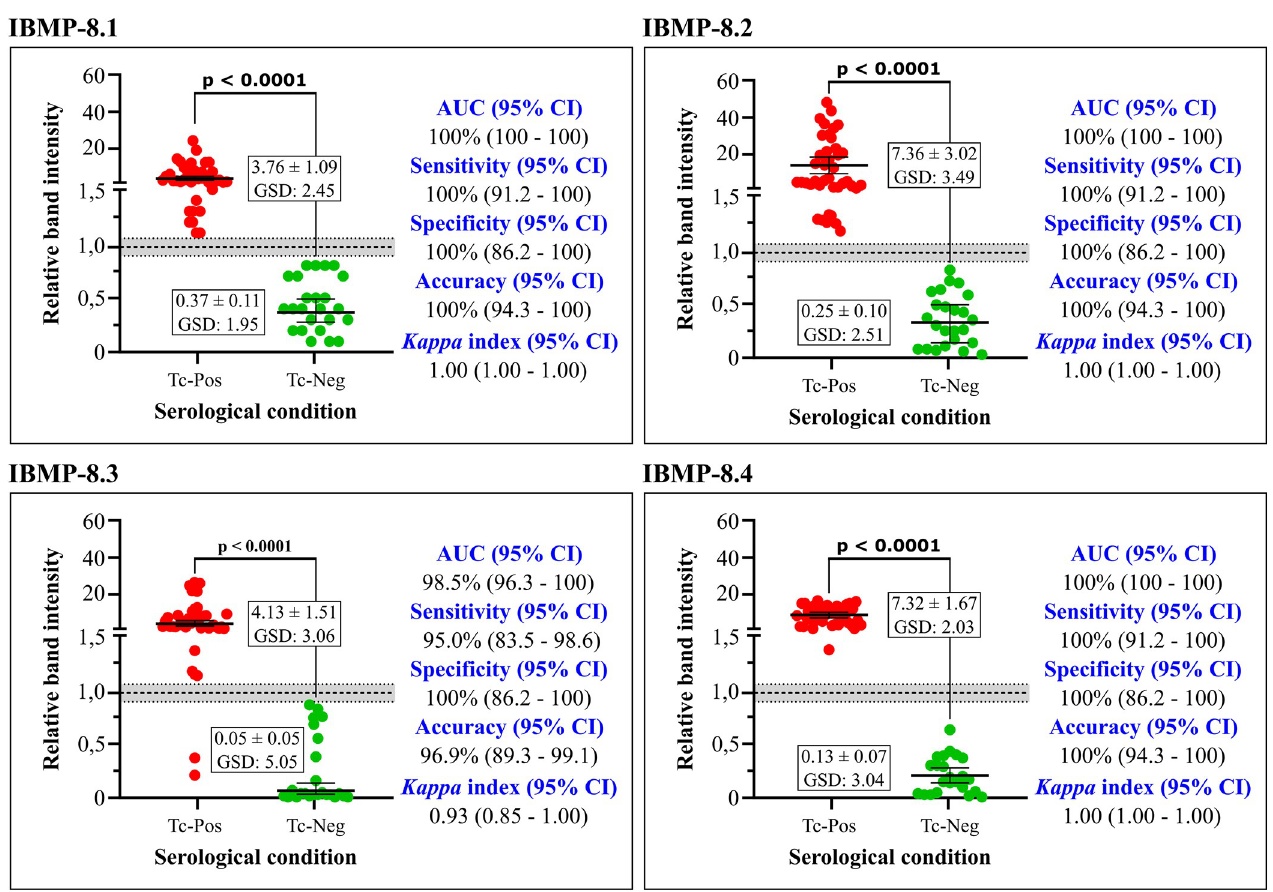
Fig 2. Relative band intensity (RBI) and diagnostic performance parameters obtained from Trypanosoma cruzi -positive (Tc-Pos) and T . cruzi -negative (Tc-Neg) serum samples. The cut-off value was set at a reactivity index value of 1.0, with the shaded area representing the grey zone (i.e., an indeterminate result; RI = 1.0 ± 0.10). Horizontal lines and numbers for each result group represent geometric means ( ± 95%CI). GSD represents geometric standard deviation.